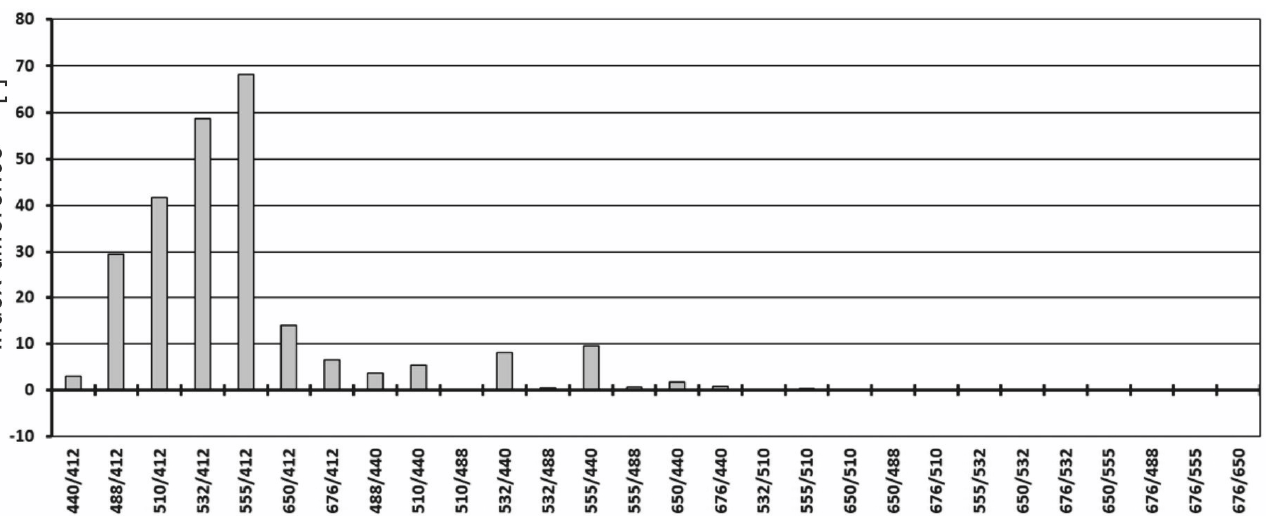
Figure 8 . Differences between the values of the spectral index for both seawater polluted with an oil-in-water emulsion and seawater free of oil.